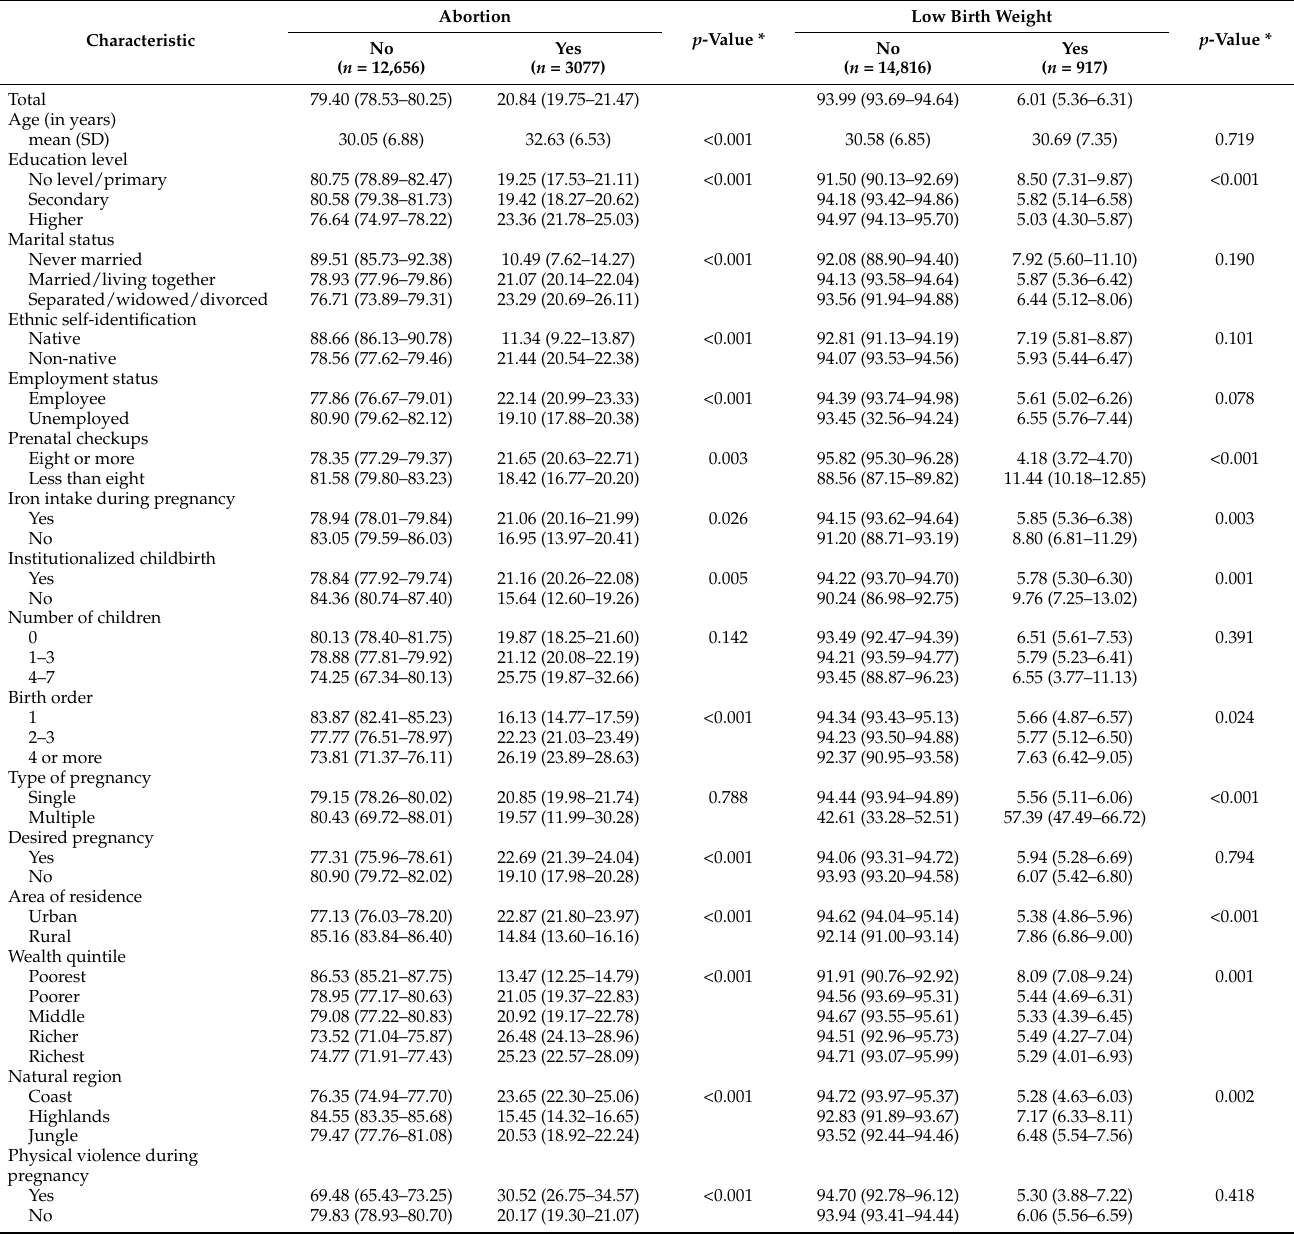
Table 3. Characteristics of women between 15 and 49 years old according to newborn outcomes, ENDES